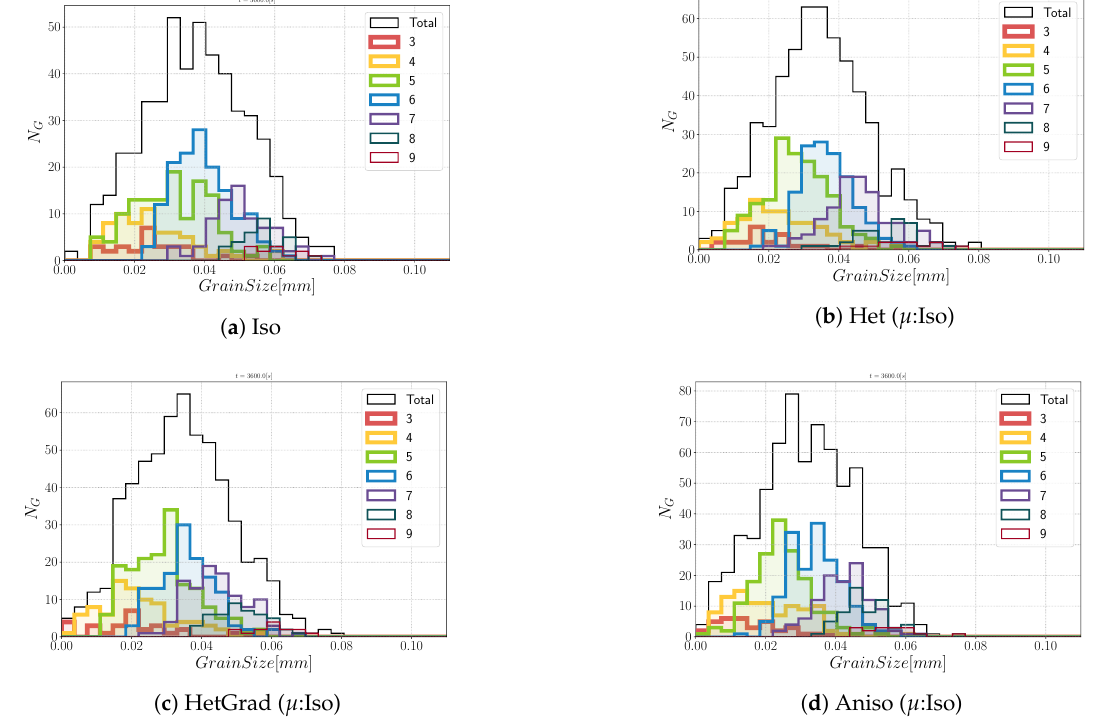
Figure A8. Grain size distribution and contributions from every group of grains of the same coordination number from 3 to 9 at t = 1